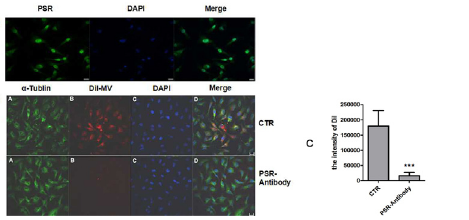
Fig 8. Blockage of PSR suppresses the engulfment of MSC-MVs by HUVECs. (A) PSR expression on the HUVECs was detected with confocal microscopy analysis. PSR: green; DAPI: the nuclear (blue); Bar: 20 μ m. (B) HUVECs were pre-treated with anti-PSR antibody and cultured in the presence of DiI-labeled MSC-MVs. Twelve hours later, the cells were fixed and observed under a confocal microscope. CTR: HUVEC with DiI-MV; PSR-Antibody: HUVEC+PSR-Antibody with DiI-MV; Bar: 20 μ m. (C) Blockage of PSR with a specific antibody greatly decreased the internalization of MVs into HUVECs ( vs .CTR *** P < 0.0001, n = 2).